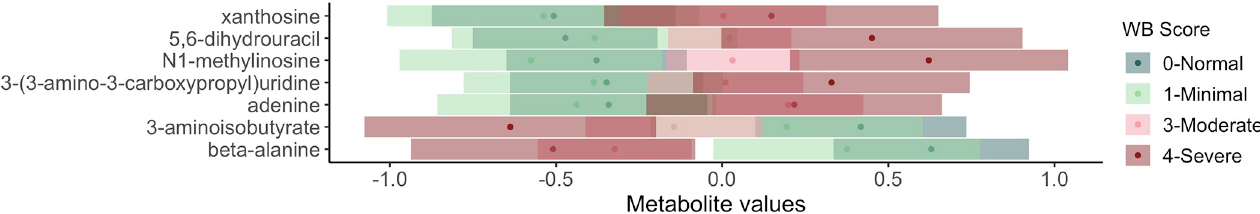
Fig 6. Association of wooden breast score with nucleotide metabolism in plasma of male broiler chickens. Results of post-hoc analysis of metabolite values by wooden breast score are shown with estimated marginal means (dots) and confidence intervals (bars). Overlapping confidence intervals indicate that there is no significant difference between the two scores. To improve visualization, metabolites are listed in order of the adjusted means for a wooden breast score of 0-Normal.